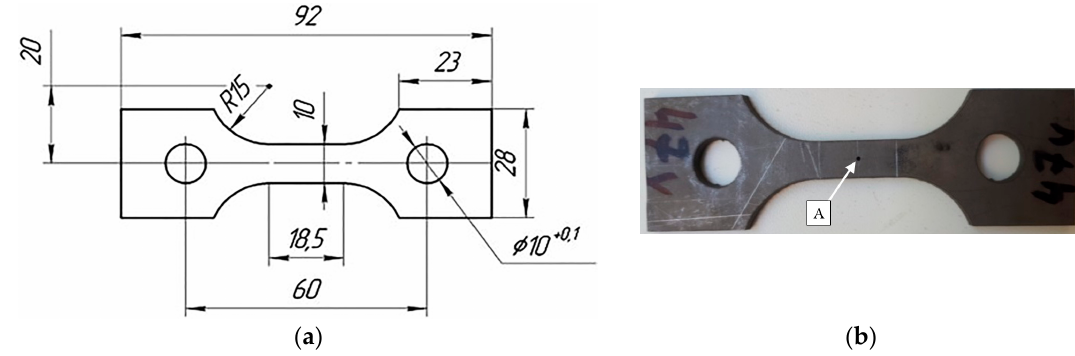
Figure 1. Specimens: for mechanical tests at static loading and DNP ( a ) and for crack resistance investigation ( b ); A—hole with a diameter of 0.8 mm. Table 2. Testing modes for specimens from high-strength titanium alloys VT22 and VT22M. Titanium Alloys Scheme of Loading